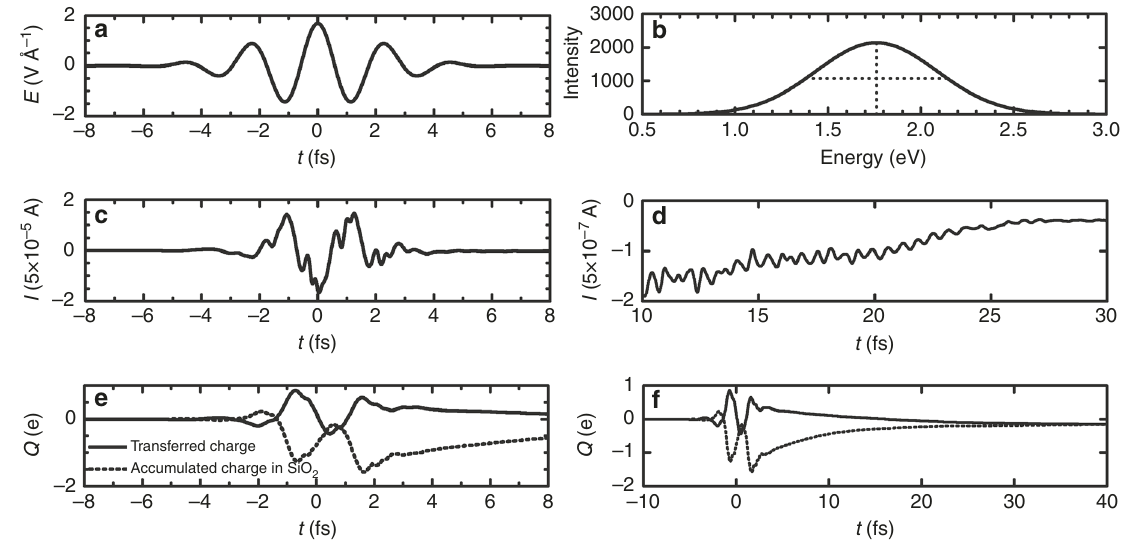
Fig. 2 Time dependence of the laser-induced currents. a – d Time-dependent currents I ( t ) during ( c ) and after ( d ) photoexcitation by the non-resonant 4 fs laser pulse E ( t ) with maximum amplitude 1.7 V Å − 1 and φ = π shown in a ( N = 6, E || a , μ F = 7.5 eV). The Fourier transform of E ( t ) quantifying its spectral content is shown in b . e , f Transferred charge (solid line) through the junction and accumulated charge (dashed line) in the SiO 2 during ( e ) and after ( f ) the pulse